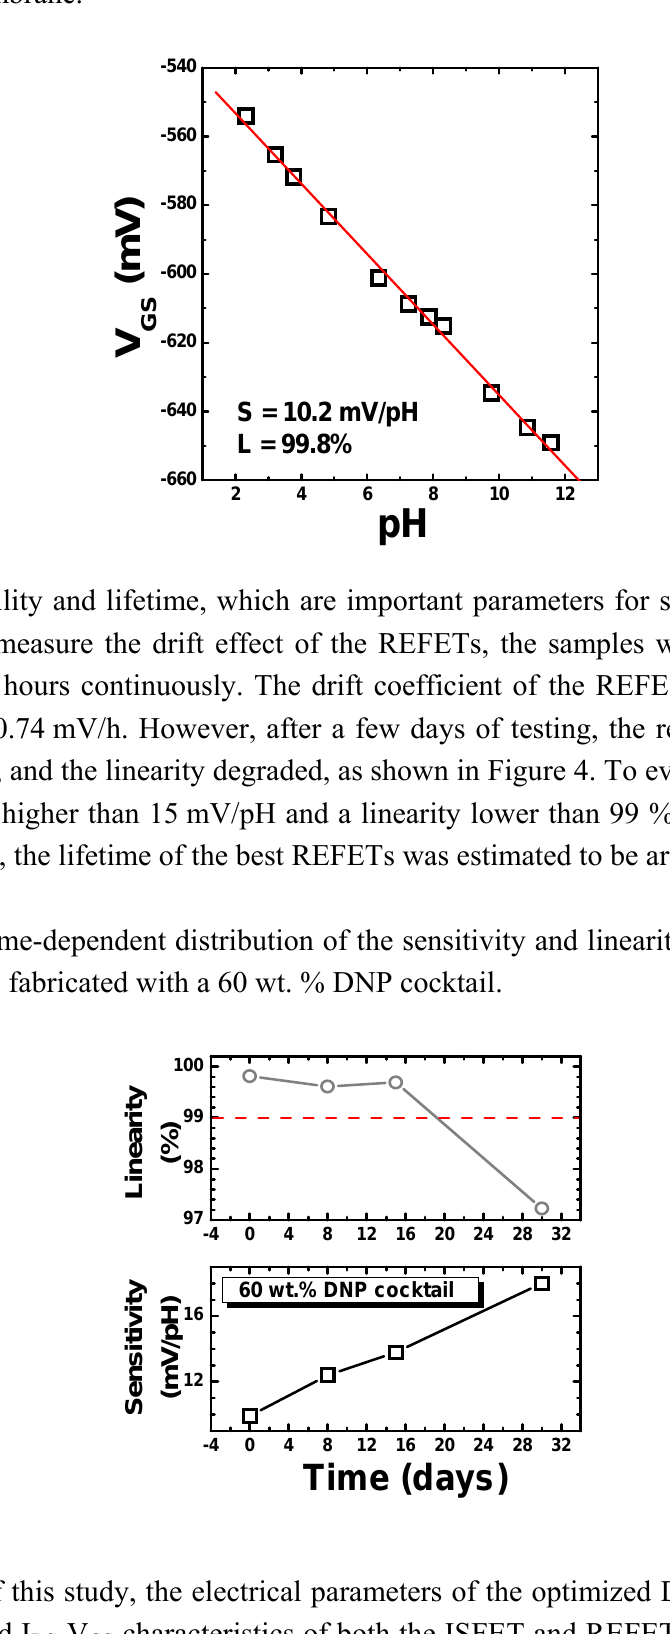
Figure 3. pH response of the REFET with the optimized composition of the DNP solution for the PVC membrane.